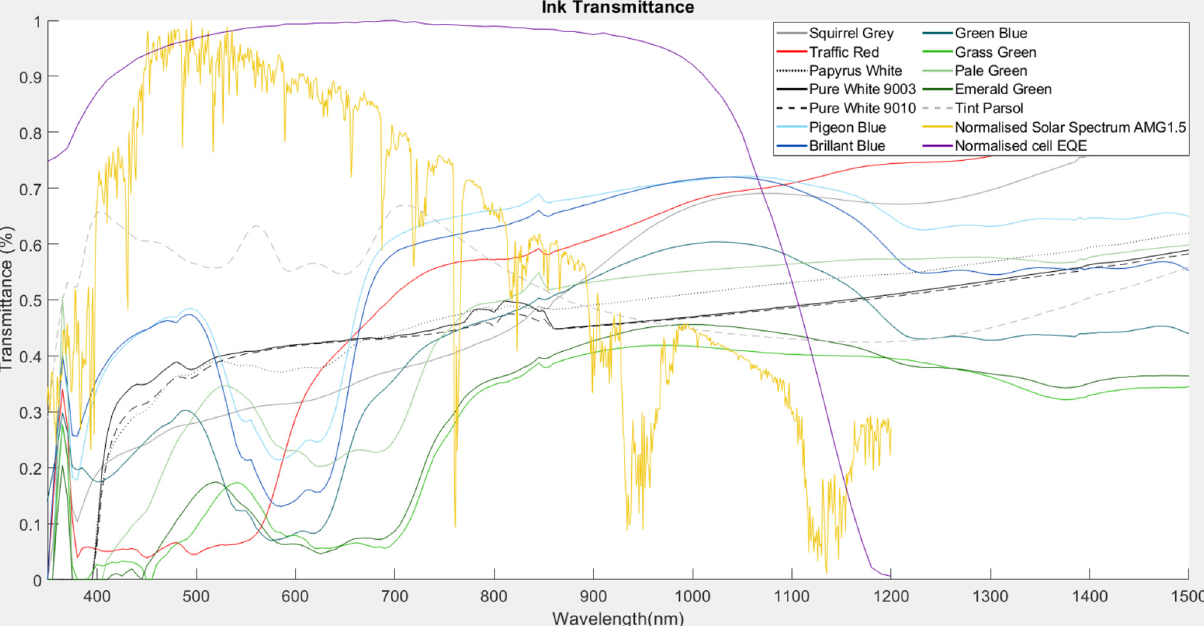
Fig. 5. Transmission spectra measured and compared for the 12 different colors of Set